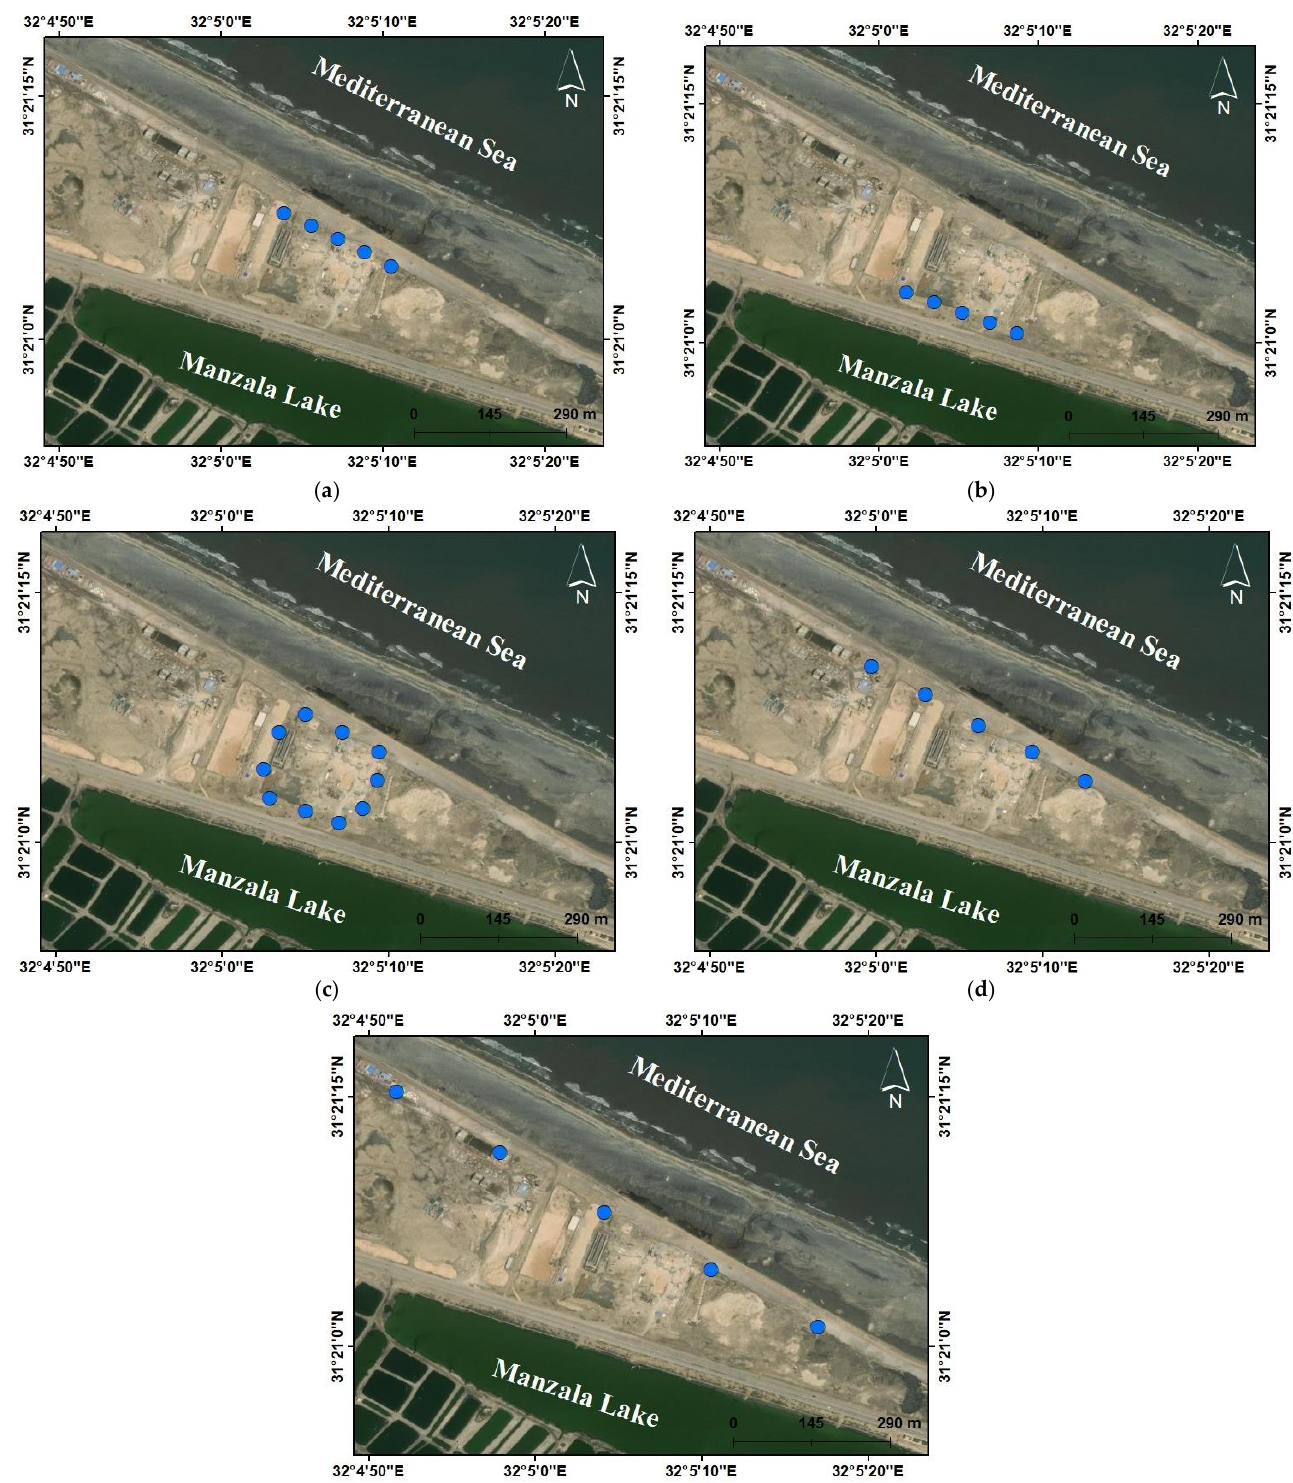
Figure 6. Arrangement of proposed pumping wells for different scenarios: ( a ) first arrangement, ( b ) second arrangement, ( c ) third arrangement, ( d ) fourth arrangement and ( e ) fifth arrangement.